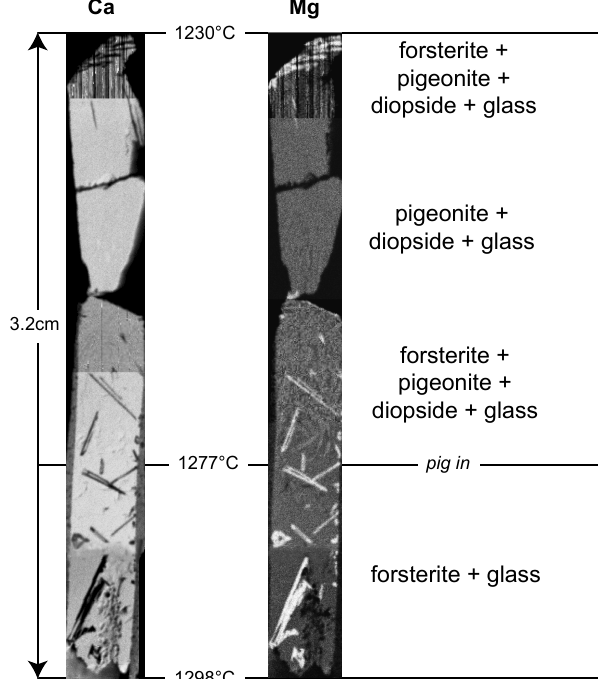
Figure 6. Photomicrographs showing olivine morphologies ob- served in dynamic crystallization experiments. Nomenclature Fig. 6. Photomicrographs showing olivine morphologies observed in dynamic crystallization experiments. Nomenclature is from Donaldson (1976) and Faure et al. (2003), respectively. a: Chain is from Donaldson (1976) and Faure et al. (2003), respec- olivine / swallowtail shape (CPX02). b: Branching olivine / swallowtail shape (CPX02). c: Hopper olivine (CPX09). d: Plate olivine / swallowtail shape (CPX09). e: Detail of dendritic tail of a tively: (a) chain olivine/swallowtail shape (CPX02), (b) branching swallowtail olivine crystal (CPX02). f: Polyhedral olivine (CPX04). olivine/swallowtail shape (CPX02), (c) hopper olivine (CPX09), (d) plate olivine/swallowtail shape (CPX09), (e) detail of dendritic tail of a swallowtail olivine crystal (CPX02), and (f) polyhedral olivine (CPX04)